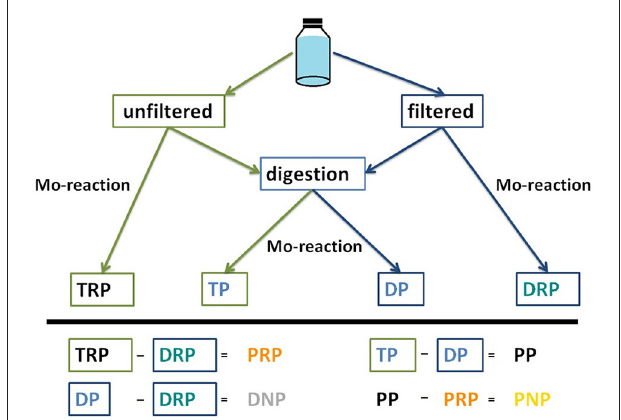
FIGURE 2 | Scheme used in the detection of the various phosphorus (P) fractions. Mo-reaction, reaction of phosphate with molybdate whereby a blue phosphomolybdate complex is generated; TP, total P; DP, total dissolved P; PP, total particulate P; TRP, total molybdate-reactive P; DRP, dissolved